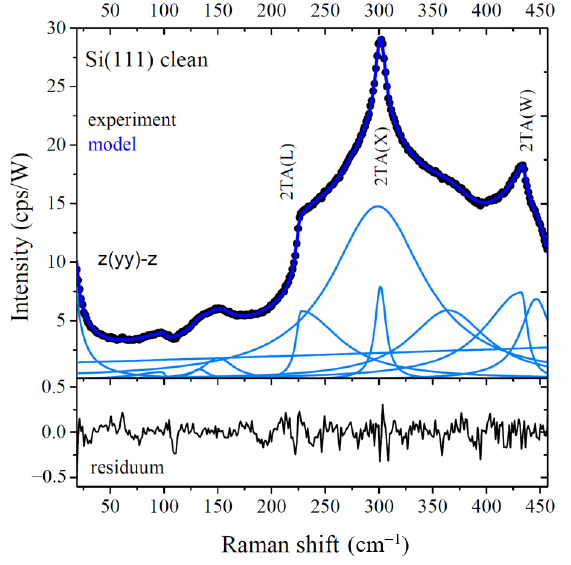
Figure A1. Parametrization of the Raman spectrum of clean Si(111). The critical points L , X , W of the 2TA band of silicon are indicated [65]. The experimental spectrum (black dots) is well approximated by the model (blue curve), as shown by the low residuum (lower panel).